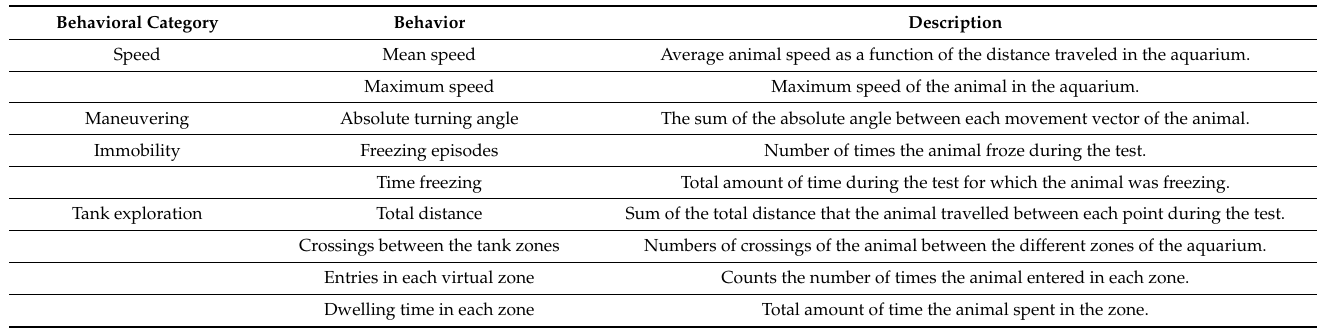
Table 1. Description of the behavioral features analyzed by ANY-maze ®